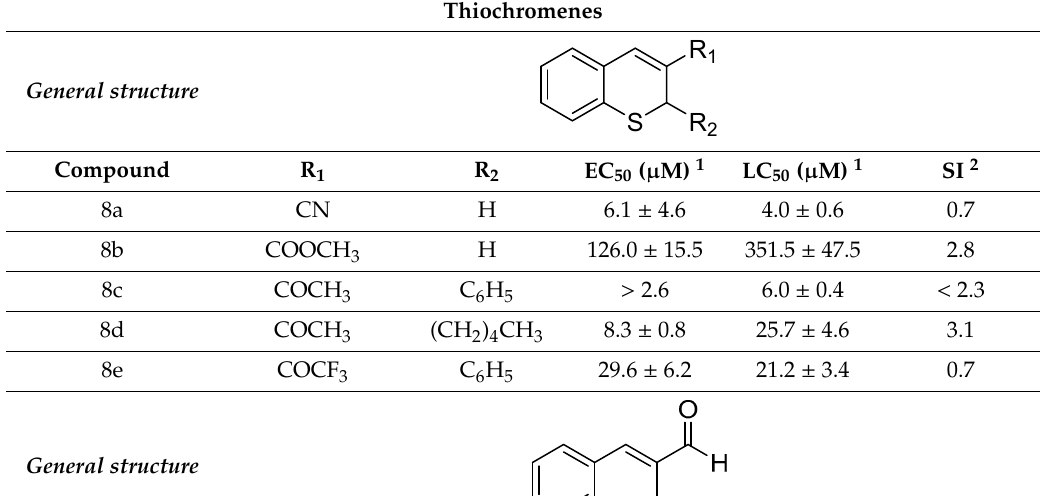
Table 1. In vitro antileishmanial and cytotoxic activities.